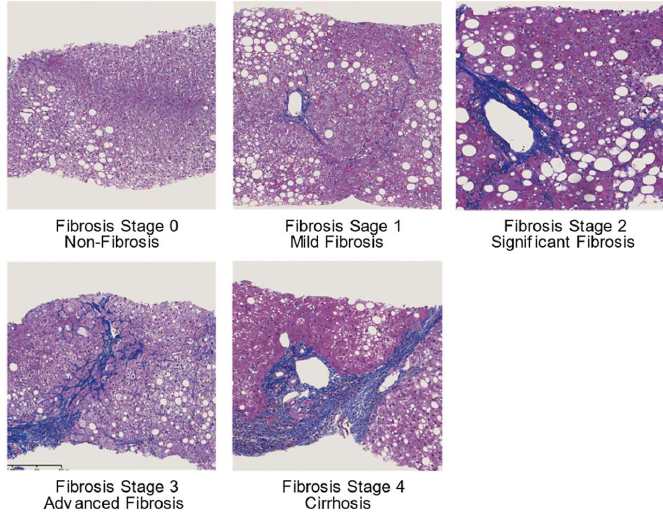
Figure 1. Liver fibrosis score in non-alcoholic fatty liver disease (Masson trichrome staining). Stage 1: Pericellular and perisinusoidal fibrosis in zone 3. Stage 2: Pericellular and perisinusoidal fibrosis with periportal fibrosis. Stage 3: Bridging fibrosis. Stage 4: Cirrhosis.